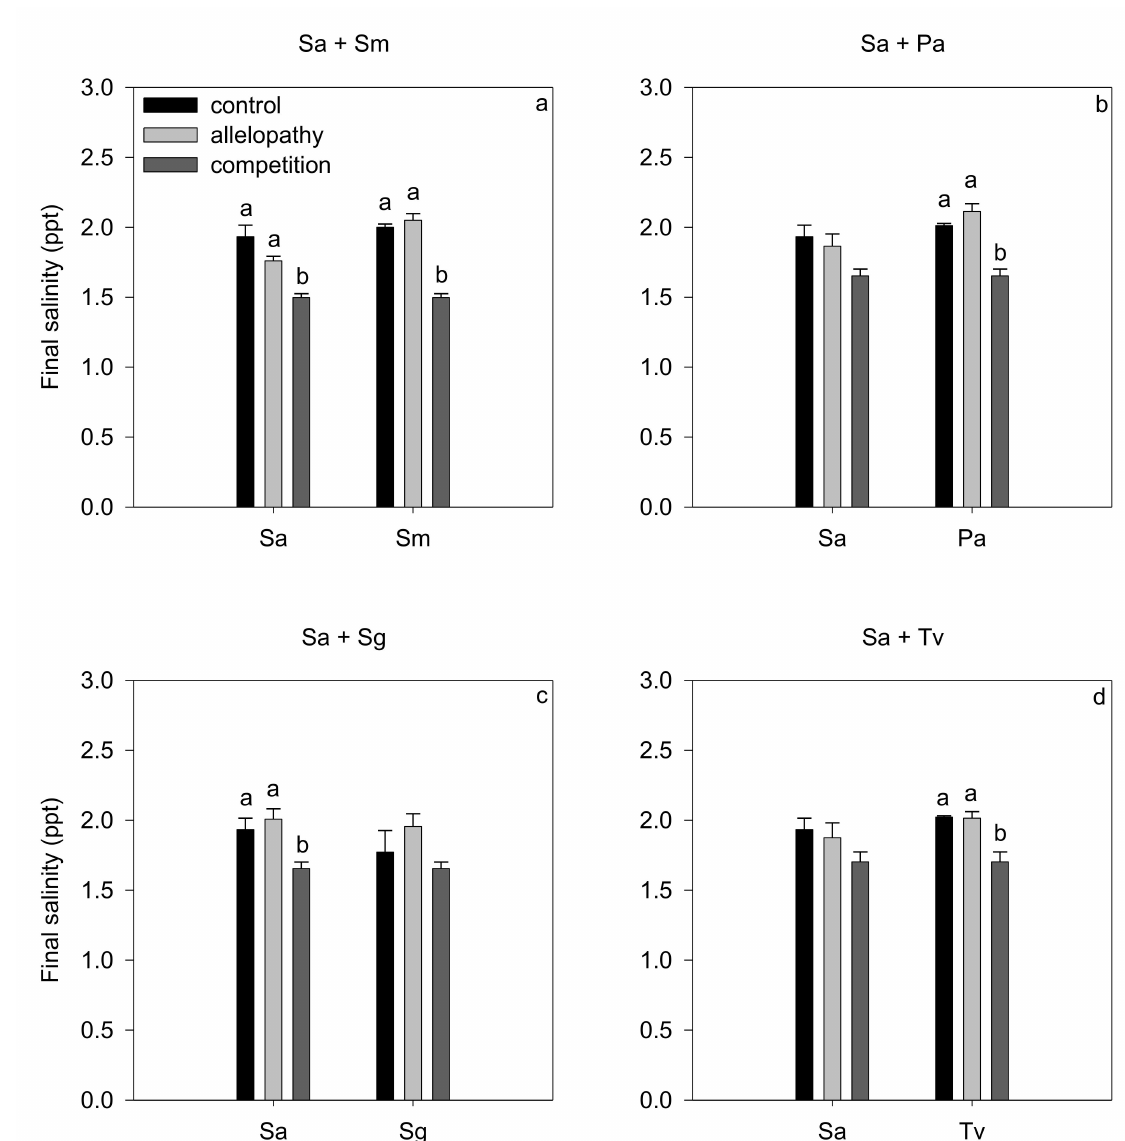
Figure 4. Final salinity of the solution in Petri dishes after germination in different interspecific interaction treatments (control: target species in monoculture, allelopathy: target species seeds + com- petitor seeds leachate, competition: target species seeds + competitor seeds in mixture). ( a ) Species combination of Sa + Sm, ( b ) Species combination of Sa + Pa, ( c ) Species combination of Sa + Sg, ( d ) Species combination of Sa + Tv. Sa: Spartina alterniflora , Sm: Scirpus mariqueter , Pa: Phragmites australis , Sg: Suaeda glauca , Tv: Tripolium vulgare . Different lower cases denote significant differences among different interspecific interaction treatments of the same species. Error bars are standard